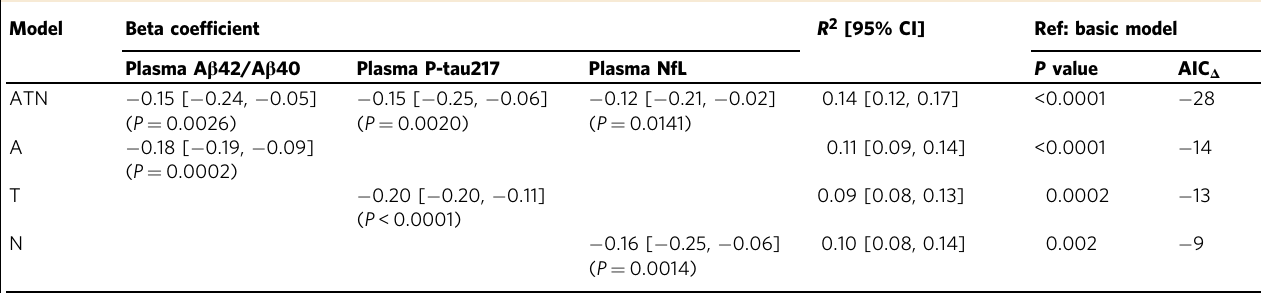
Table 2 Association between plasma biomarkers and longitudinal PACC.